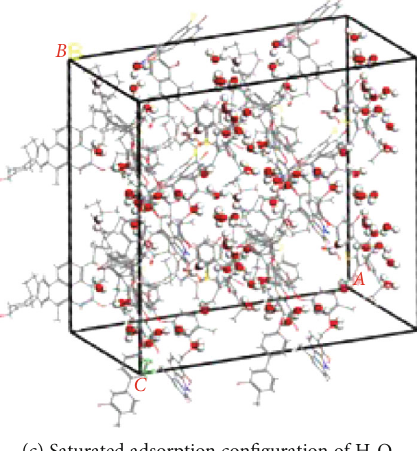
, CO , and H O adsorbed on lignite. Color scheme: C: black; H: gray; O: red; N: blue; S: 4 2 2